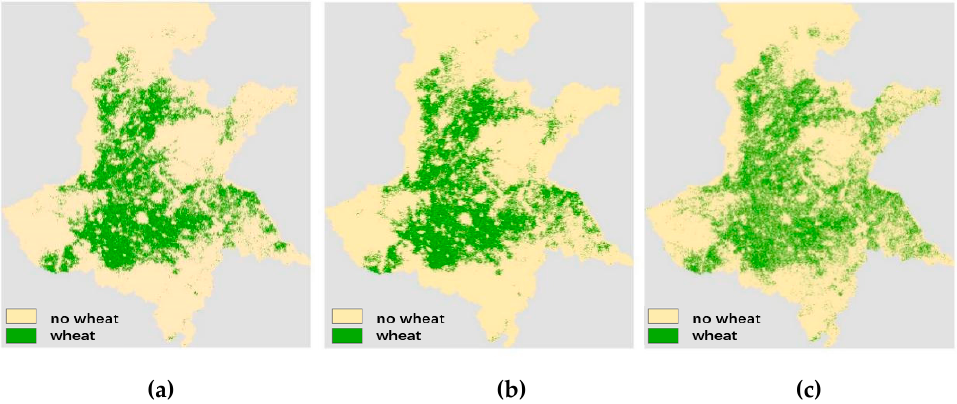
Figure 8. ( a ) The prediction map informed by the RF model, ( b ) the prediction map informed by the A-LSTM model, ( c ) ground truth winter wheat distribution map. A-LSTM model, ( c ) ground truth winter wheat distribution